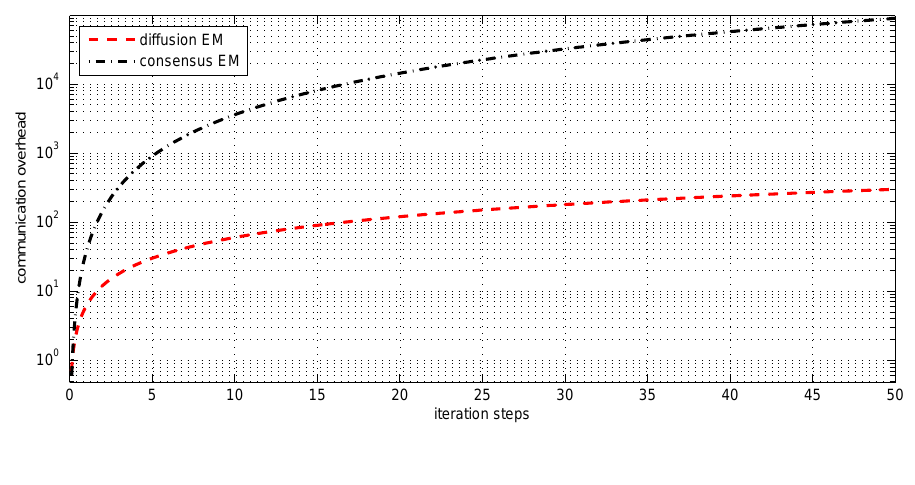
Figure 4. Communication overhead for diffusion EM and consensus EM.